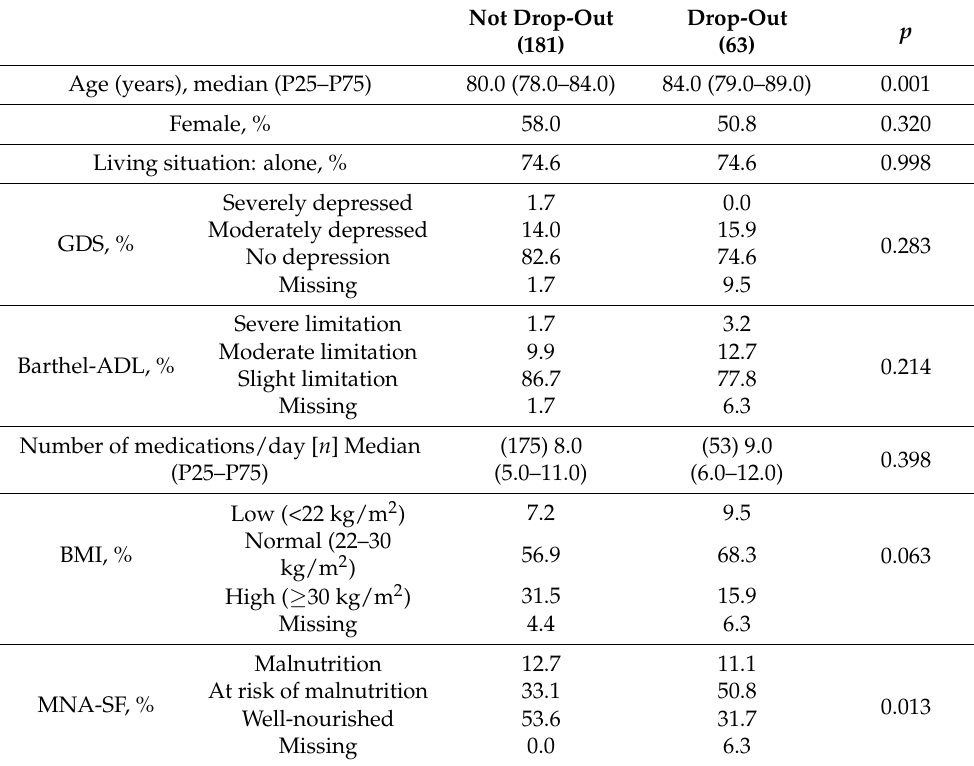
Table A1. Baseline characteristics of participants at baseline (T0) for those who completed the study vs. those who dropped out from the